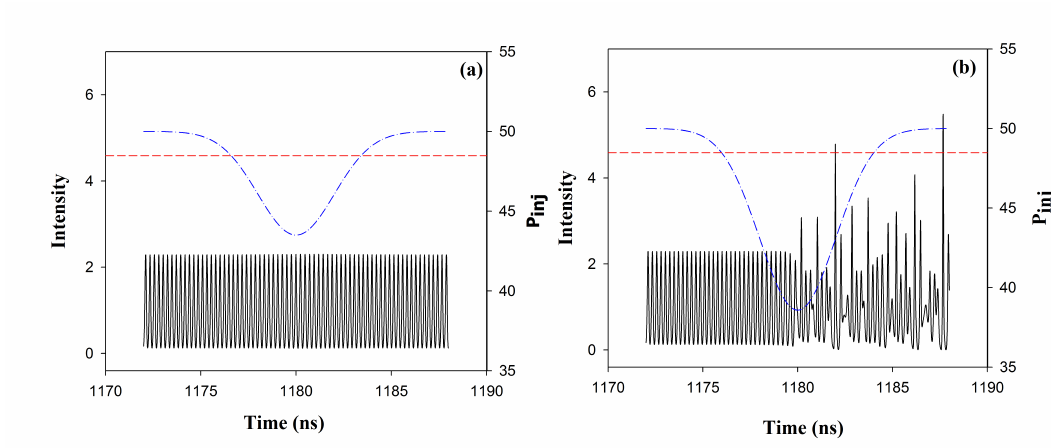
Figure 2. Time series of the laser intensity when the variation of the injected power is ∆ P = 6.6 ns − 2 ( a ) and ∆ P = 11.4 ns − 2 ( b ). In panel ( a ) we see that the variation is small and the intensity is always below the threshold, therefore, the variation of P inj is not detected. In contrast, in panel ( b ), ∆ P is large enough to trigger the emission of intensity pulses that are high enough to cross the threshold (indicated with a dashed line).